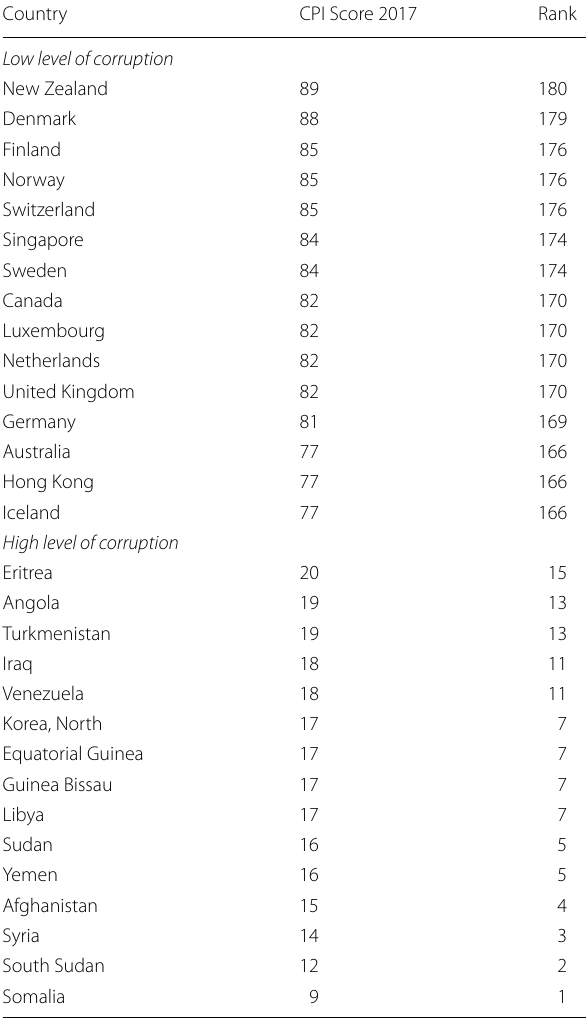
Table 2 Corruption score of selected